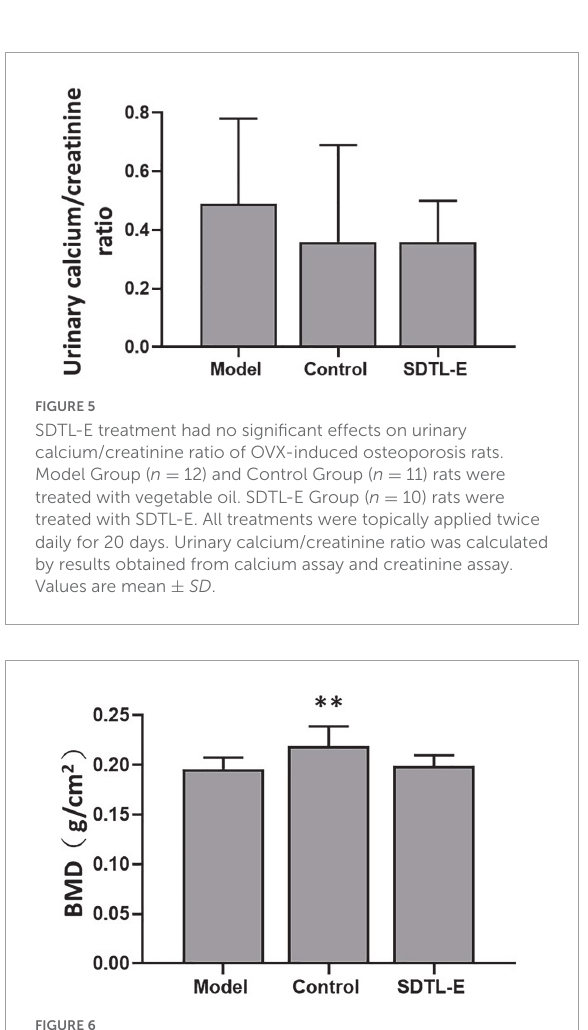
FIGURE6 SDTL-E treatment had no significant effects on BMD of OVX-induced osteoporosis rats. Model Group ( n = 12) and Control Group ( n = 11) rats were treated with vegetable oil. SDTL-E Group ( n = 10) rats were treated with SDTL-E. All treatments were topically applied twice daily for 20 days. BMD was determined by performing bone densitometry evaluation on the right femur. Values are mean ± SD . ∗∗ p < 0.01 vs. Model